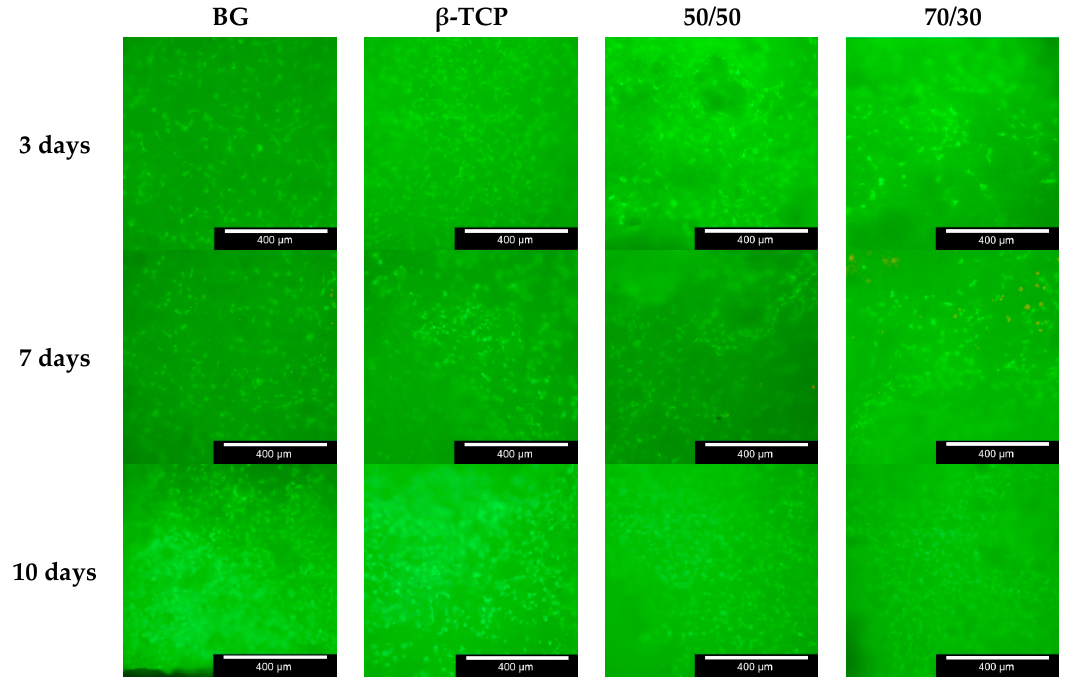
Figure 7. Live/dead assay images of the inner surface of the scaffolds, captured with Olympus BX 51 fluorescence microscope, broadband blue excitation with interference band-eliminator filter U-MWIB3: excitation filter Olympus BP460-495, beam splitter Olympus DM505, band-eliminator filter BA510F; living cells, green; dead cells, red. The scale bar is 400 µm. Table 6. Comparison of living and dead cells per mm² on the different materials.